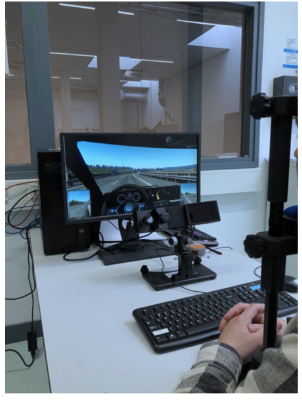
Figure 1. Experimental setup. Shown from back to front is the monitor for displaying the videos, the eye-tracker camera with infrared illuminator, the keyboard used for pressing the spacebar and arrow keys, and the head support. keys, and the head